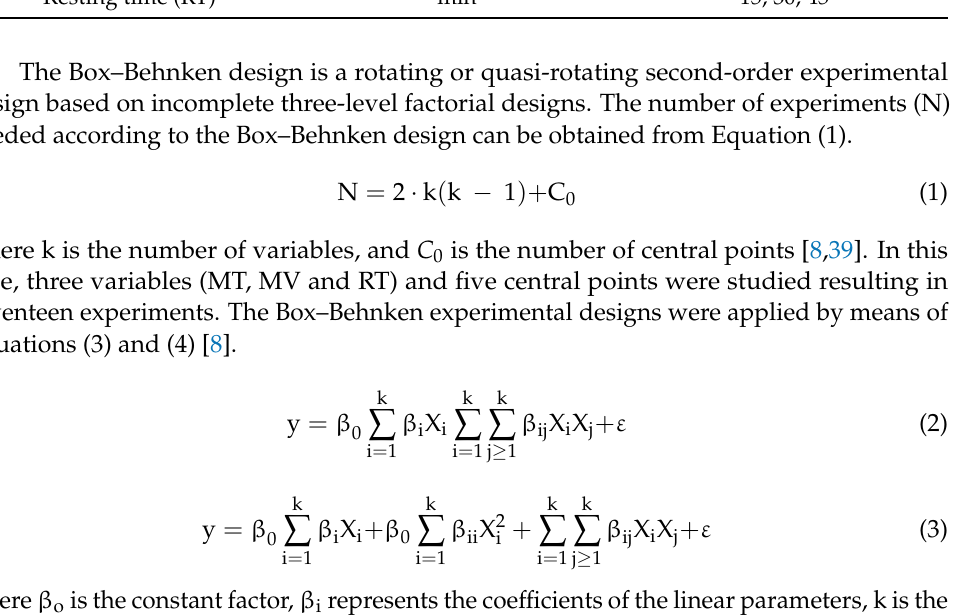
Table 3. Individual dependent variables and their range of values. Variable Units Studied Range Mixing time (MT) min 5; 15; 25 Mixing velocity (MV) Rpm 100; 175; 250 Resting time (RT) min 15; 30;